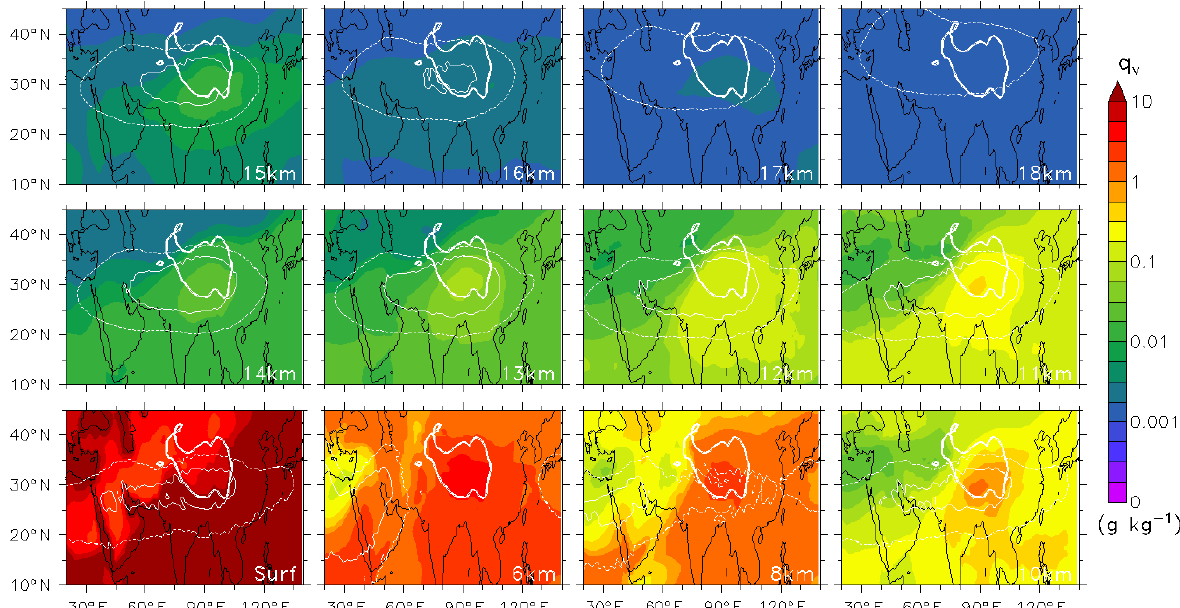
Figure 13. EMAC-simulated specific humidity, q v , in units of gram of water vapor per kilogram of air (gkg − 1 ), at selected altitudes, i.e., at the surface and 6, 8, 10, 11, 12, 13, 14, 15, 16, 17, and 18kma.s.l., averaged for July–August 2012. Thin white lines refer to the contour of pressure deviation, as defined in Fig. 2, and thick white lines highlight the Tibetan Plateau